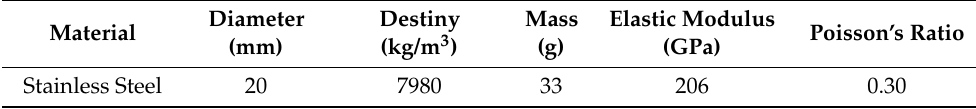
Table 1. The mechanical properties of the projectile.